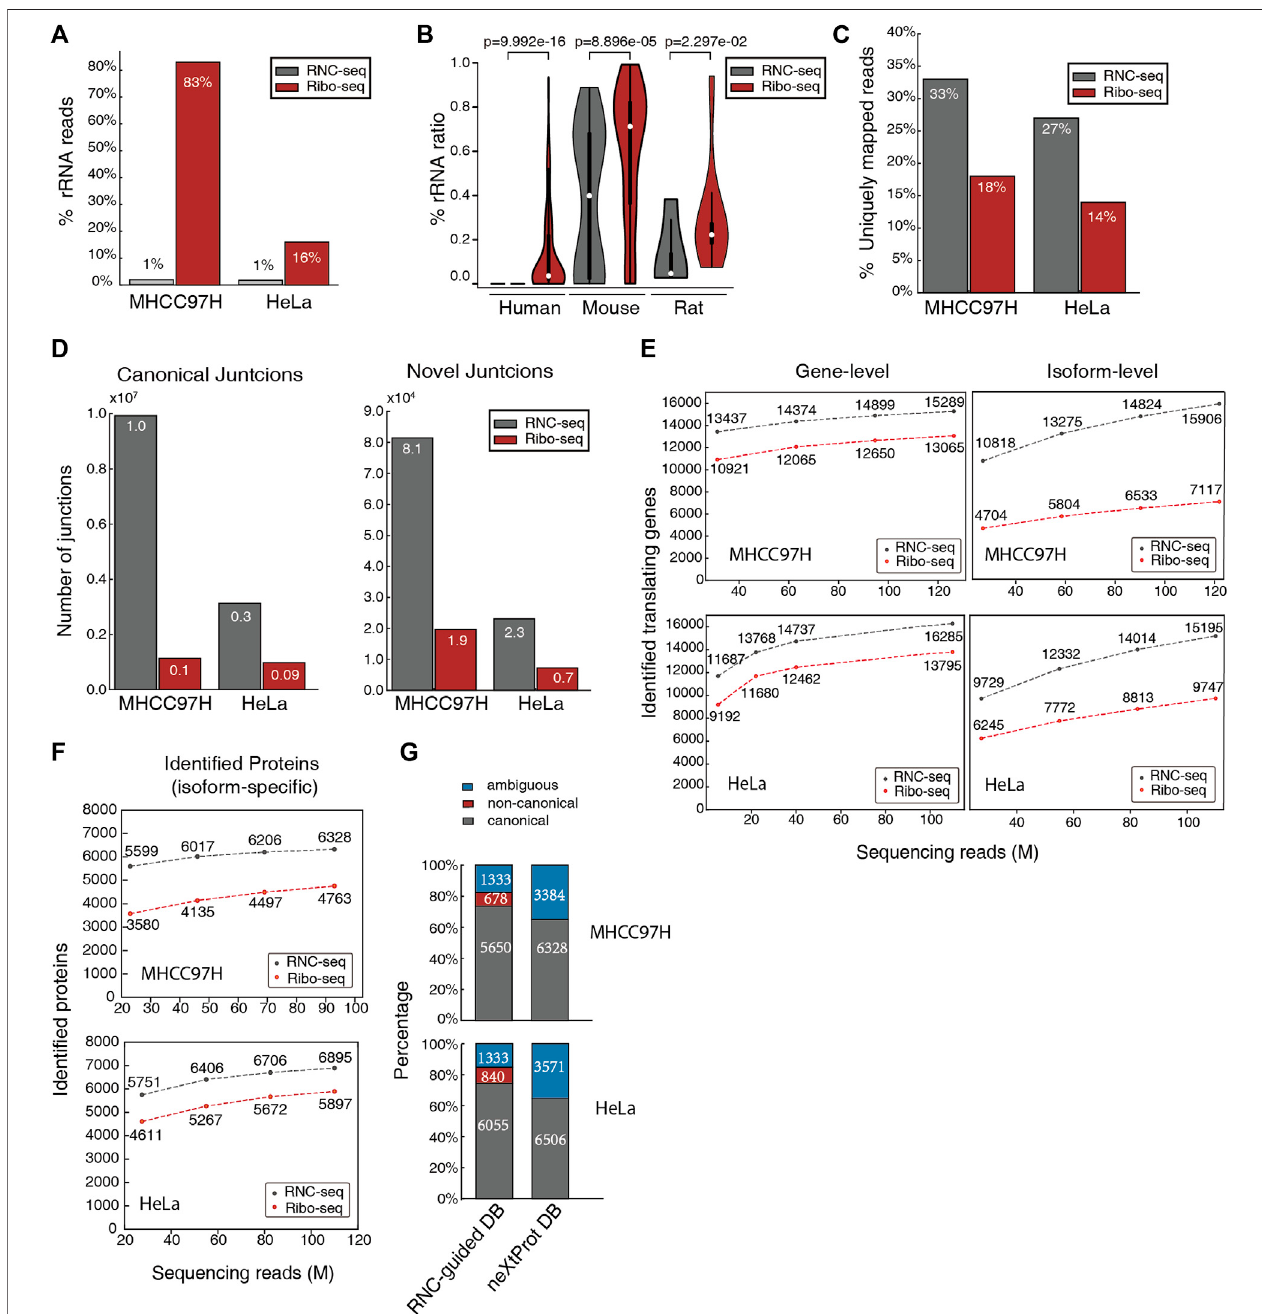
FIGURE 1 | RNC-seq ’ s advantages over Ribo-seq in detecting splicing isoforms with higher ef fi ciency. (A) Percentage of rRNA reads in RNC-seq and Ribo-seq datasets of MHCC97H and HeLa cells. (B) Percentage of ribosomal RNA reads in RNC-seq and Ribo-seq datasets in human, mouse, and rat. The p -values were obtained from Kolmogorov-Smirnov test. (C) Percentage of uniquely mapping reads (uni-mapped reads/non-rRNA reads) in RNC-seq and Ribo-seq. (D) Number of identi fi edcanonicaljunctions(left) and noveljunctions(right) using same number ofnon-rRNA reads (25M). (E) Numberofidenti fi ed genesand isoformssupported byuniquelymappedreadsunderthesamethroughputofrawreads. (F) Numberofproteinisoformsidenti fi edbyusingRNC-seqandRibo-seqguidedproteindatabase. (G) Proportionofidenti fi eddistinctproteinsbyRNC-seqguided databaseandneXtProt.Ambiguous:theseproteinssharealltheirpeptideswithotherproteins,andthus cannot be unambiguously identi fi